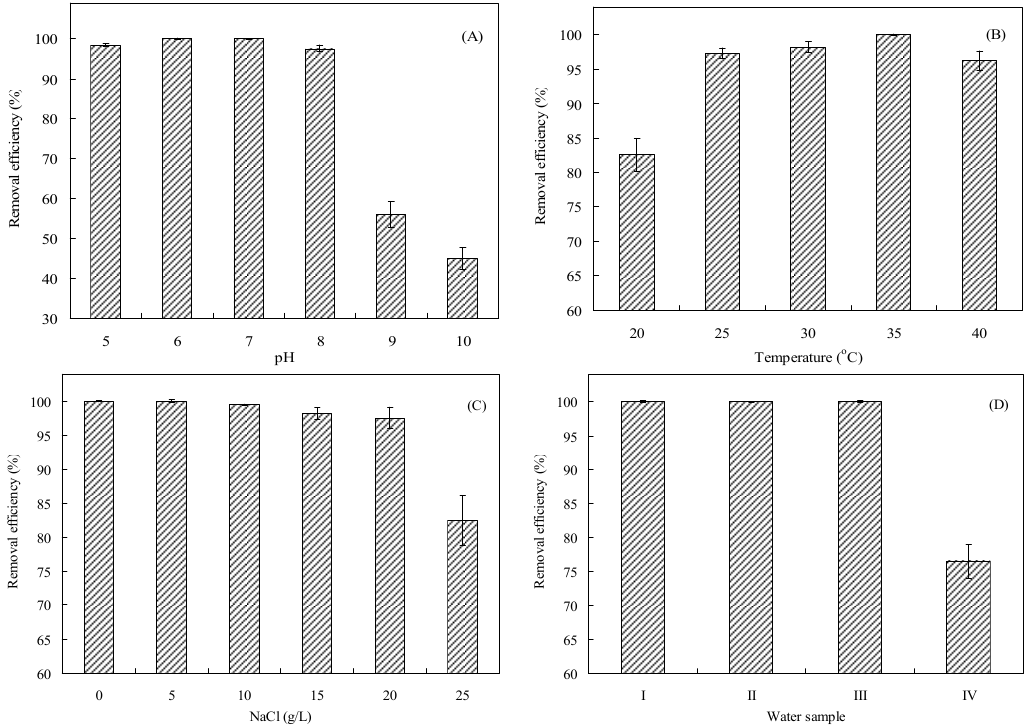
Figure 1. Effects of ( A ) pH (temperature: 30 °C, NaCl concentration: 0 M); ( B ) temperature (pH: 7, NaCl concentration: 0 M); ( C ) NaCl concentration (temperature: 30 °C, pH: 7); and ( D ) various water